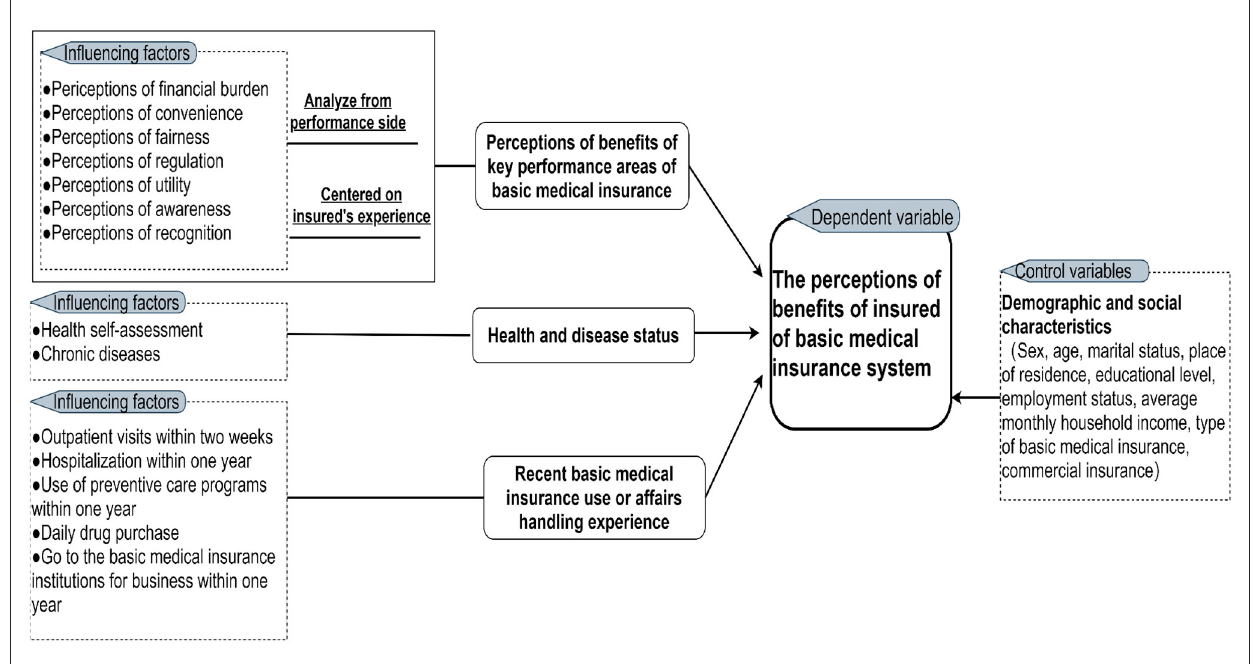
FIGURE1 Analytical framework of the PBBMI of the